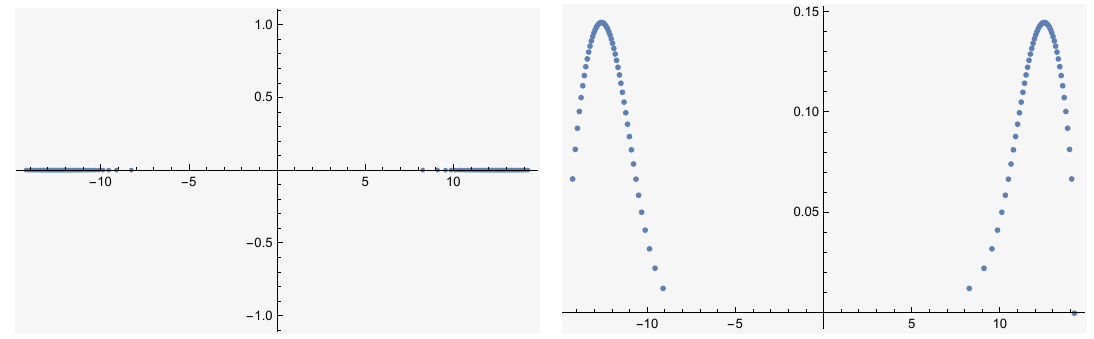
Figure 3 . The left figure shows the other numerical solution plotted on the Complex plane with ( N, N f , m ) = (100 , 3 , 8). The solution actually lies on the real axis. The right one shows the density function of